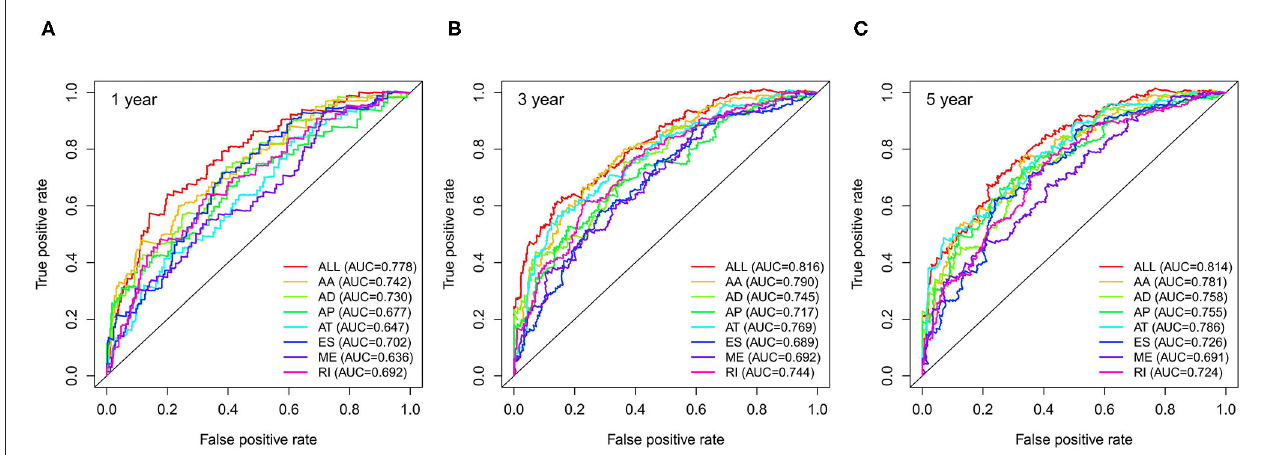
FIGURE 6 | ROC curves with AUCs of eight prognostic models in 1 year (A) , 3 years (B) and 5 years (C) . ROC, receiver operating characteristic.